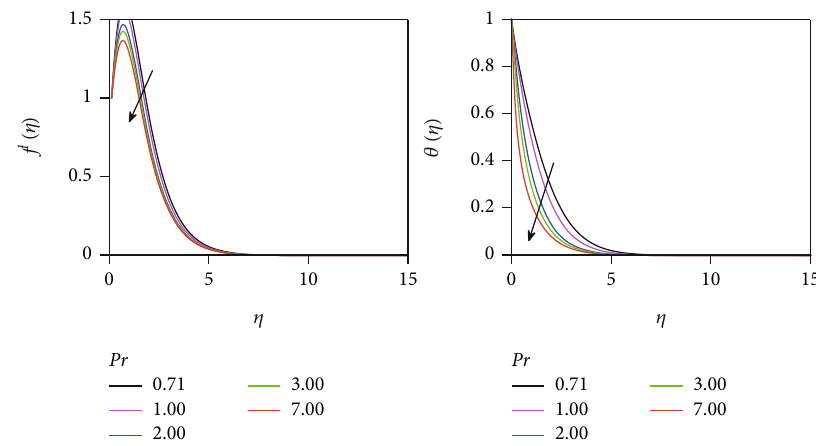
Figure 8: Signi fi cance of the Prandtl number on velocity and temperature plots.